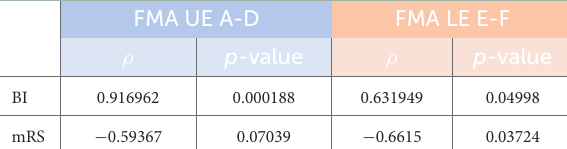
TABLE 3 Spearman correlation test